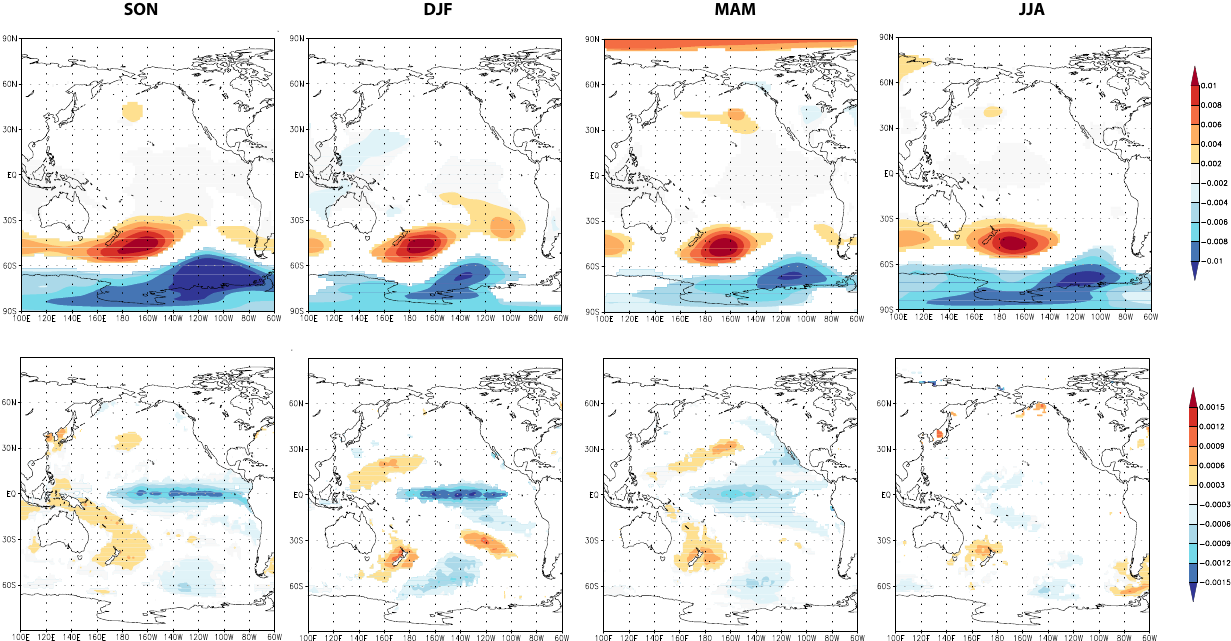
Figure 10. Contoured regressions between detrended and deseasonalised southwestern Pacific (SWP) sea level pressure and Pacific-wide 20CR sea level pressure (a–d) (Compo et al., 2011), and sea surface temperatures (SSTs) (e–j) (Rayner et al., 2003) (1979–2013) during September–November (SON), December–February (DJF), March–May (MAM) and June–August (JJA). Significance p field <0.1%. Analy- ses were made with KNMI Climate Explorer (van Oldenborgh and Burgers, 2005). Note the significant inverse relationship between SWP, tropical western Pacific sea level pressure and central and east tropical Pacific SSTs during September–November, December–February and March–May (but not June–August), a region and seasons closely associated with tropical Pacific variability (Collins et al.,